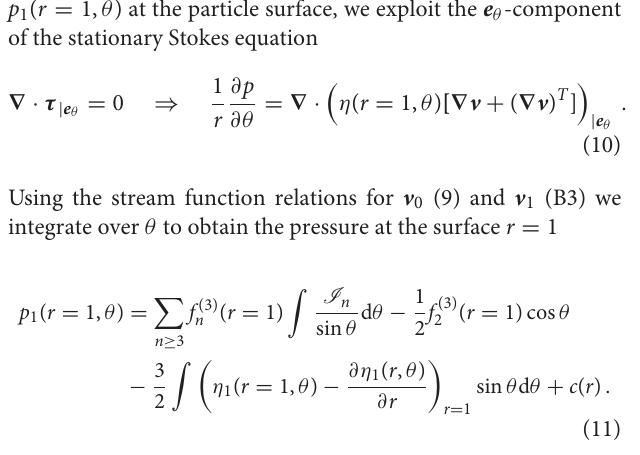
p 1 ( r = 1, θ ) at the particle surface, we exploit the e θ